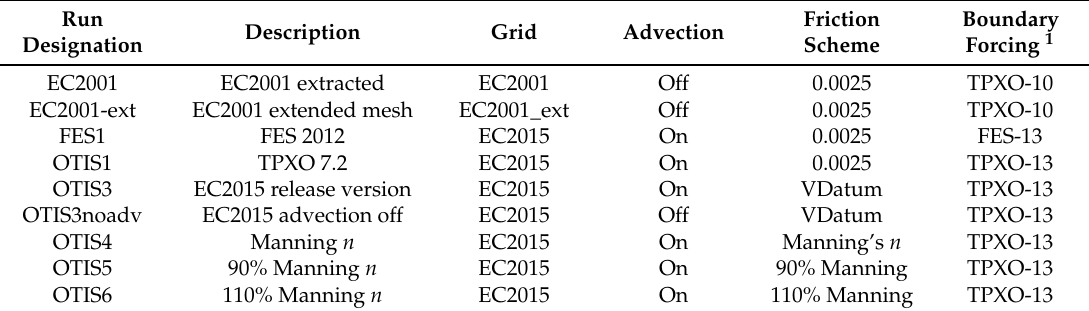
Table 4. Summary of model parameters for the model simulations completed in this